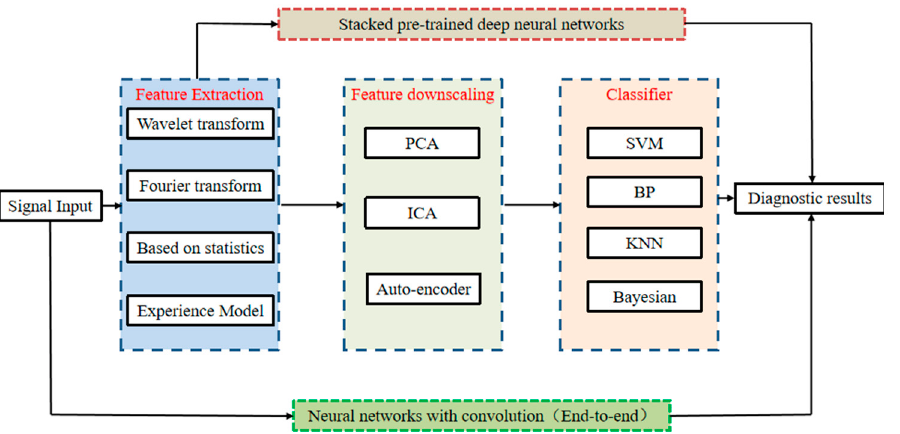
Figure 2. Intelligent fault diagnosis method.